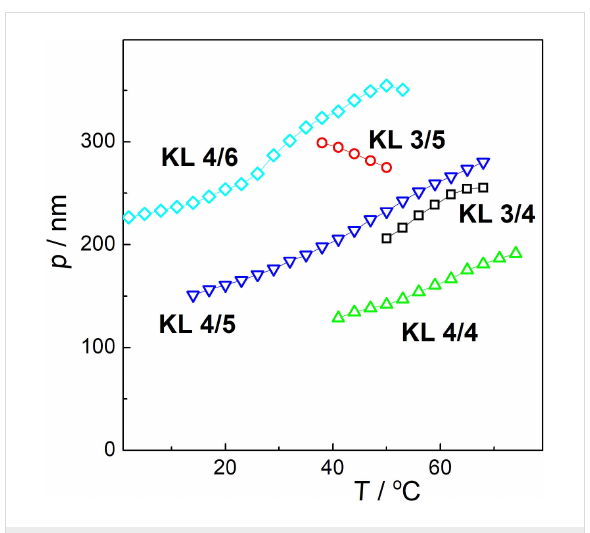
Figure 3: Temperature dependencies of the helix pitch length p for KL 3/4 (black rectangle), KL 3/5 (red cicle), KL 4/4 (green triangle), KL 4/5 (blue triangle) and KL 4/6 (cyan diamond) as